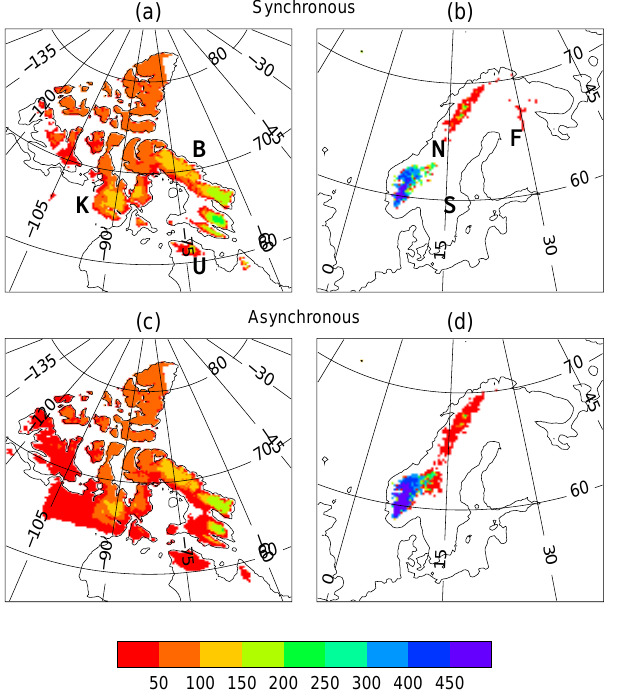
Fig. 6. Ice-sheet time-mean thickness (m) in years 401–500 of the ( a , b ) synchronous and ( c , d ) asynchronous simulations for the in- cipient glacial climate. The letters in ( a , b ) indicate the locations of the Keewatin region, Baffin Island, the Ungava Peninsula, Norway, Sweden and Finland.